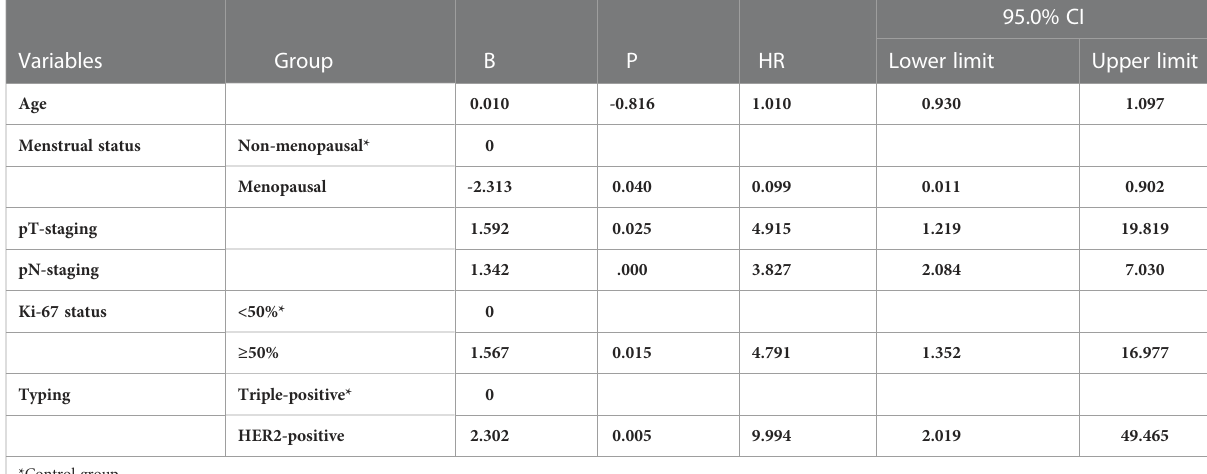
TABLE 9 Multifactorial Cox analysis of the 5-year overall survival of 135 breast cancer patients.